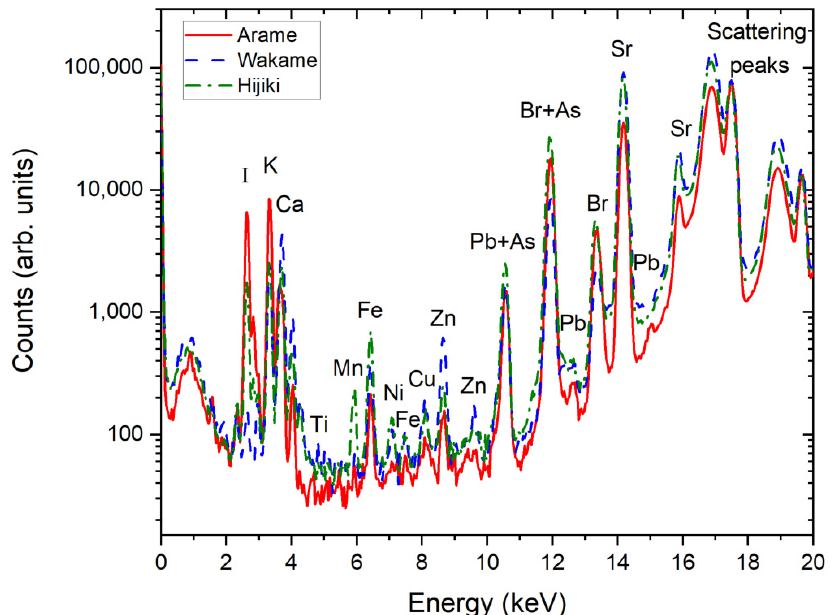
Figure 2. X-ray spectra of one sample of Arame, Wakame and Hijiki. The characteristic peaks of most of the major and trace elements are presented in the graph, where some overlap between Pb, As and Br are evident. The existence of isolated Pb peaks allows for correct quantification of each of these three elements. The two doublets at the right side of the spectra are the Compton and Rayleigh peaks from X-ray scattering in the secondary Mo target.